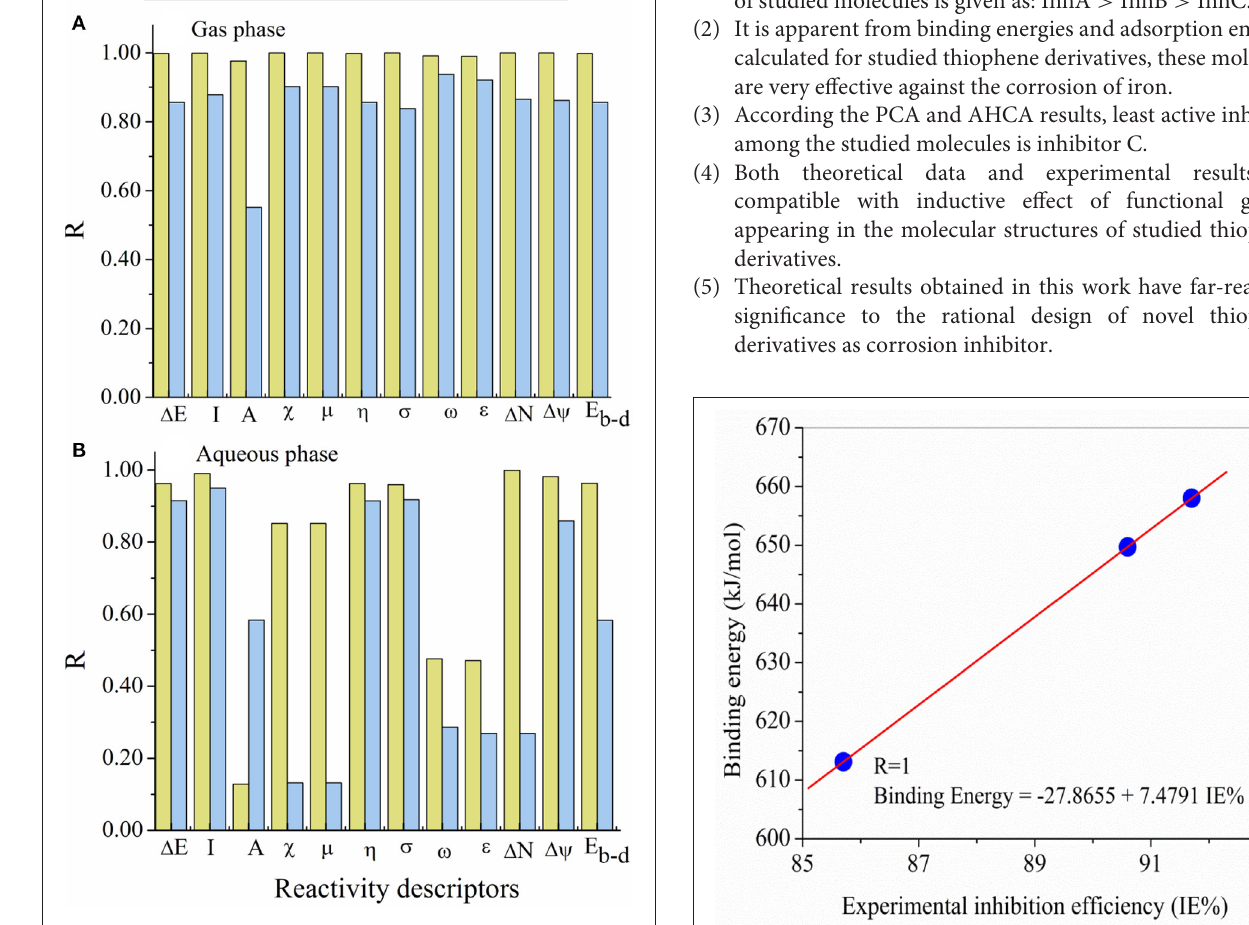
FIGURE 7 | Comparisons made between experimental anticorrosion efficiencies and theoretical binding energy obtained in the study.